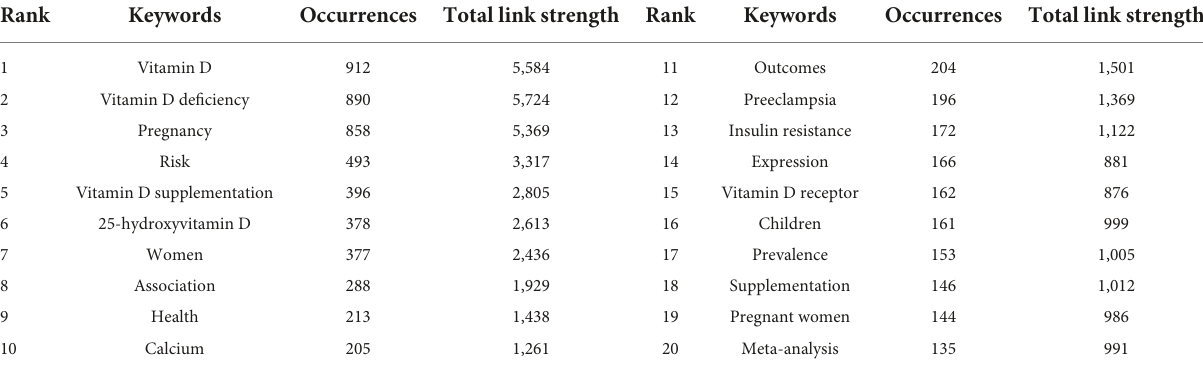
TABLE 8 The top 20 keywords in the studies of vitamin D and reproductive